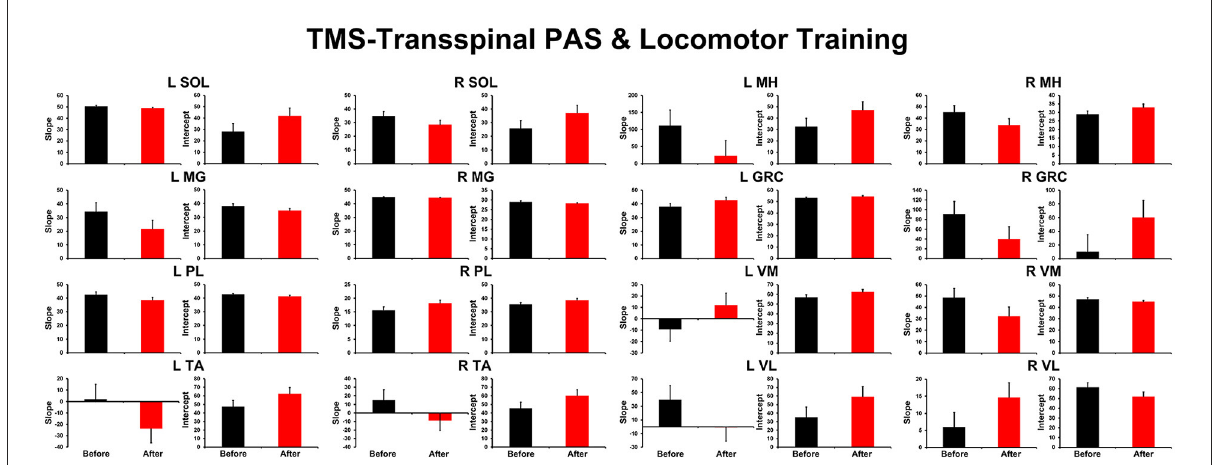
FIGURE4 Overall amplitude of slope and intercept for TEPs recorded from left and right leg muscles. For each subject and muscle, a linear regression was applied to the normalized TEP amplitude plotted against the homonymous background EMG activity before and after TMS-transspinal PAS and locomotor training. An asterisk indicates a significant difference before and after intervention. Error bars indicate the SEM. TMS, transcranial magnetic stimulation; PAS, paired associative stimulation; TEPs, transspinal evoked potentials.